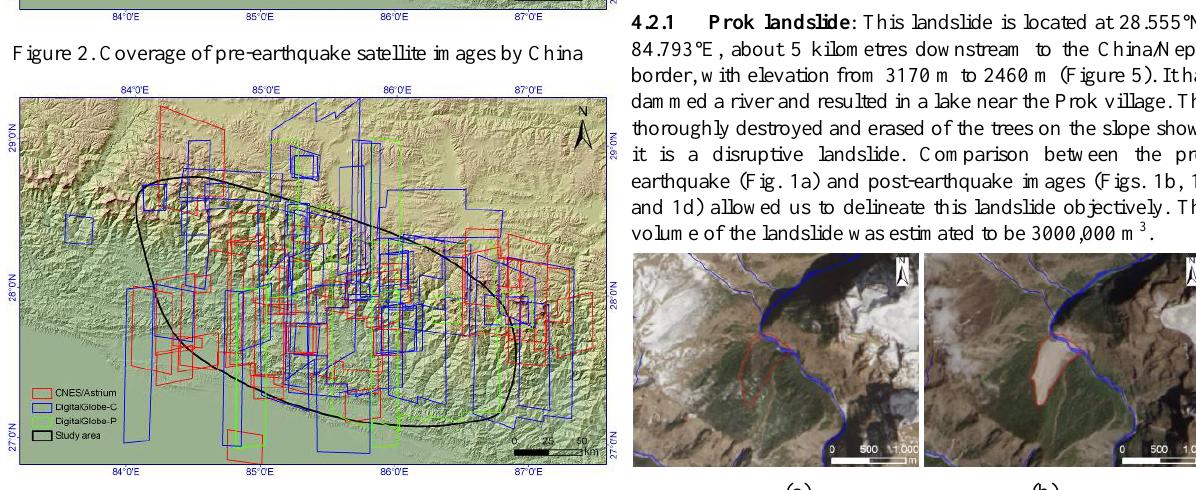
Figure 3. Coverage of pre-earthquake satellite images from Google Earth Figure 5. Satellite images show the Prok landslide dam. (a) Landsat 8 image taken on March 13, 2015, 15 m resolution; (b) Landsat 8 image taken on April 30, 2015, 15 m